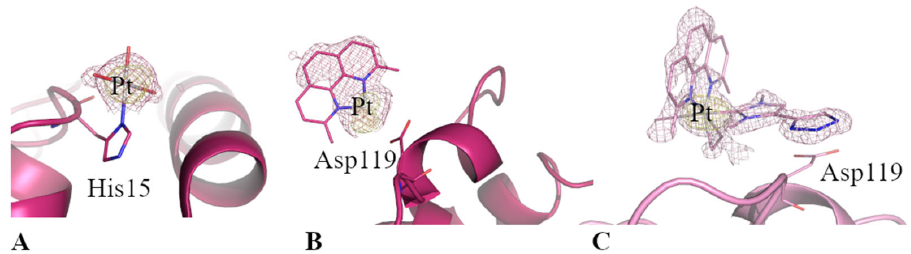
Figure 9. Pt binding sites in Structures A (panels A and B ) and B (panel C ). Atoms were placed where we were confident of their assignment. The 2Fo ‐ Fc maps (violet) are shown at the 1.0 σ values. An anomalous difference electron density map (yellow) is shown at the 3 σ contour level. The Pt atoms are shown in grey.